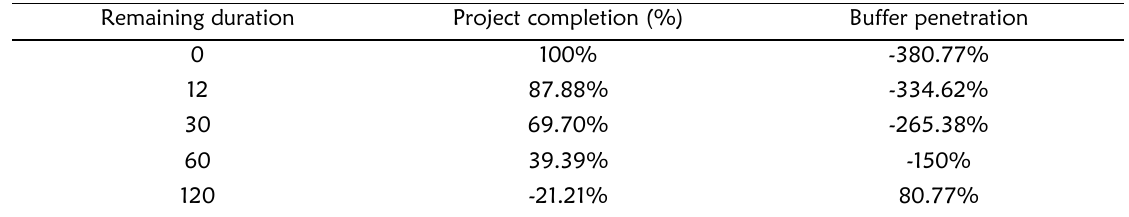
Table 3: Result of